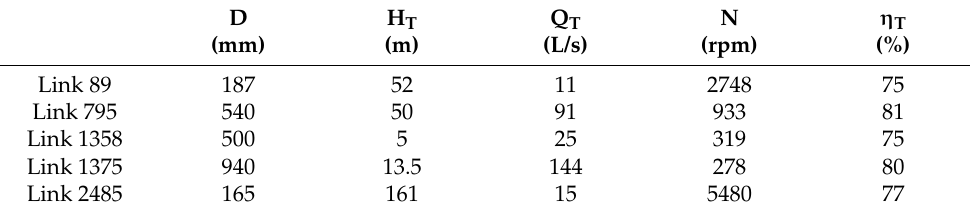
Table 3. Turbine geometry resulting from case (I).